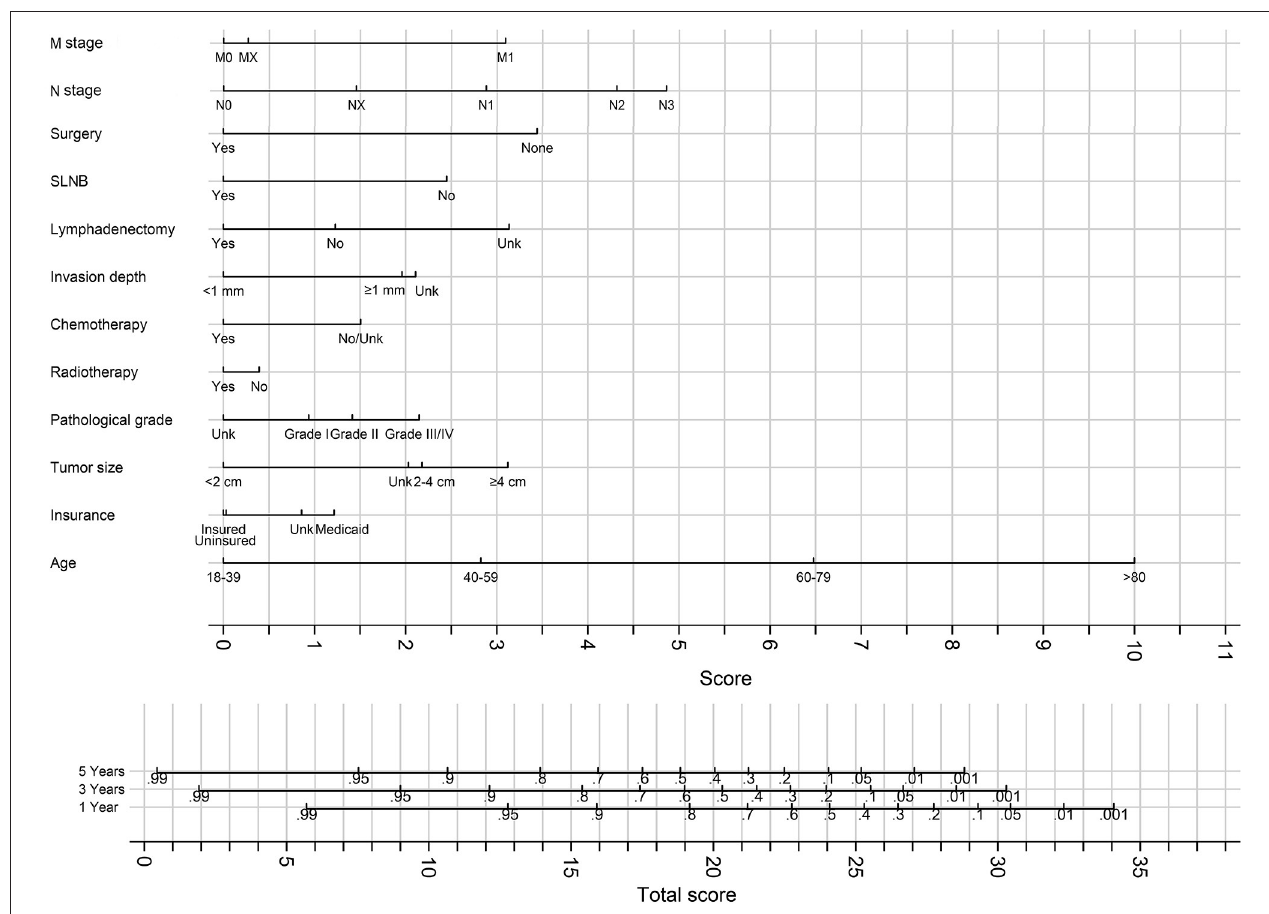
FIGURE 8 | The nomograms for predicting 3- and 5-years OS. Unk, unknown.